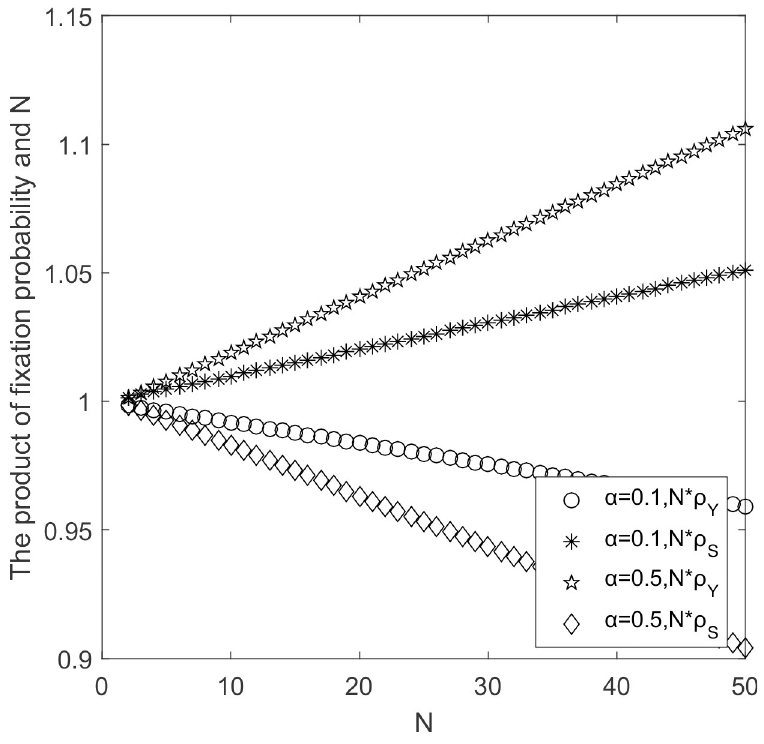
Fig 6. N � ρ Y /N � ρ S ~ α change